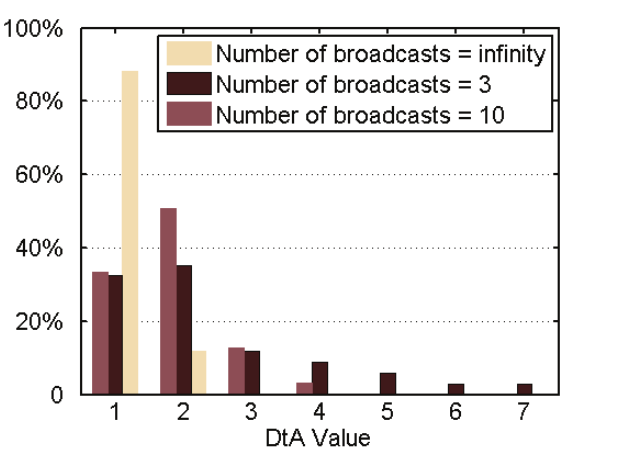
Figure 7. Distribution of DtA value in three different cases.